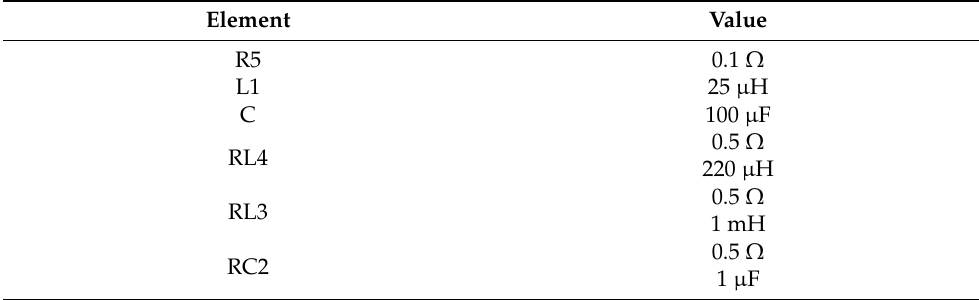
Table 2. Values of elements in filter